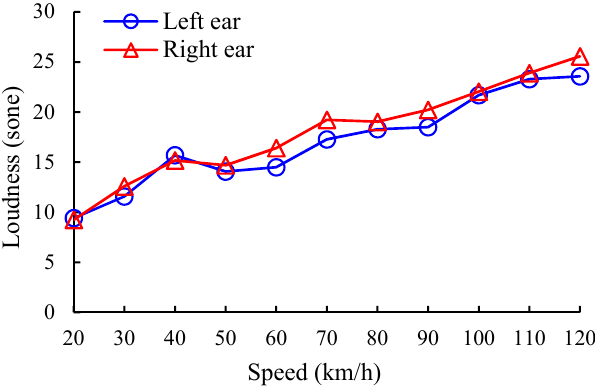
Figure 6. Interior noise loudness in the EV as a function of the vehicle’s speed.